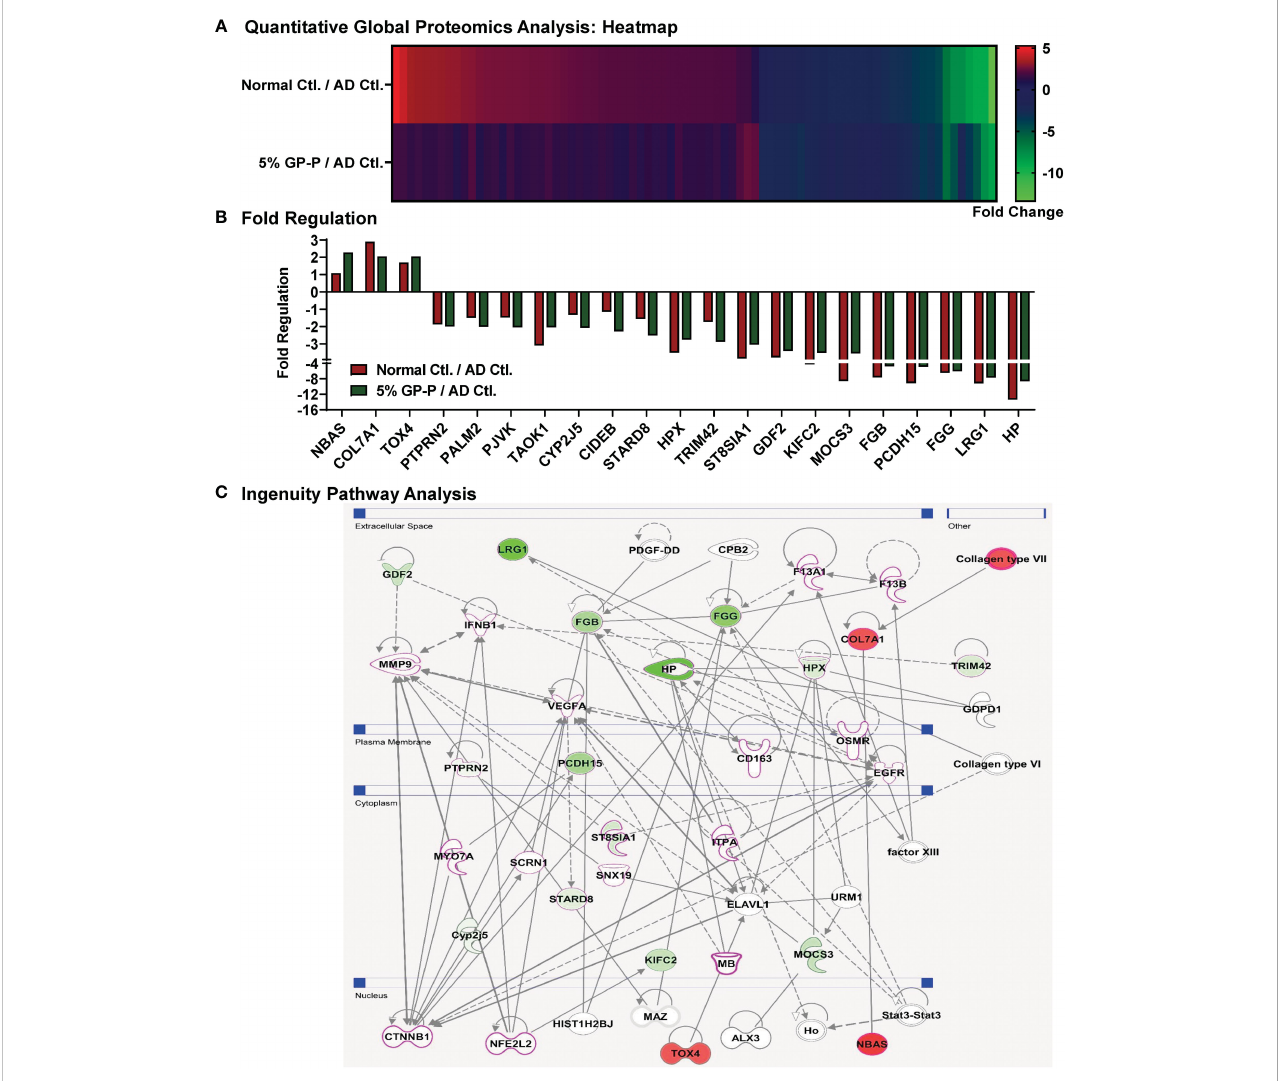
FIGURE 5 Quantitative global proteomics analyses of biological responses of grape powder supplementation against atopic dermatitis. Proteomics analyses from protein lysates (n=6 each) derived from normal control, AD control and 5% GP prevention were performed as described in ‘ Materials and Methods ’ and ‘ Figure S7 ’ sections. (A) Heatmap of 79 proteins showing ≥ 2-fold change with statistical signi fi cance in 5% GP or normal control compared to AD control was plotted. (B) Compared to AD control, 21 of these proteins signi fi cantly modulated ≥ 2-fold in 5% GP group were plotted along with normal control for comparative analysis. (C) The 21 proteins identi fi ed in response to GP were subjected to network pathway analyses using IPA. The protein-protein interactions are indicated by arrows. The solid lines denote a robust correlation with partner genes, and dashed lines indicate statistically signi fi cant but less frequent correlations. The pink outline indicates that their role in AD/other dermatological conditions is known. Green fi ll indicates downregulated proteins and red fi ll indicates upregulated